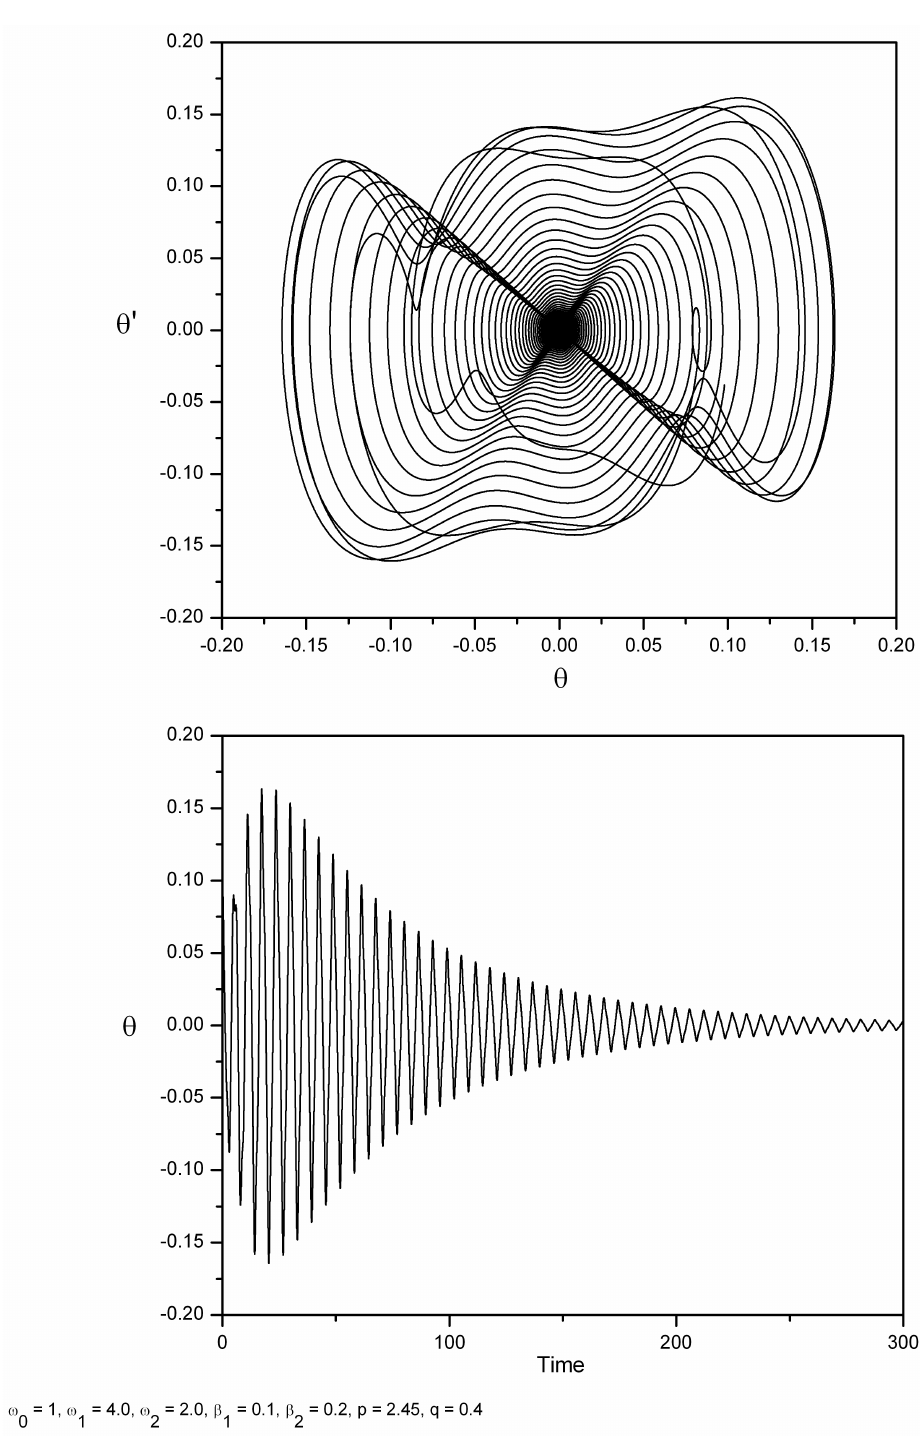
= 4 and ω = 2 for the 1 2 = 1 , β = 0 . 1 , β = 0 . 2 , p = 2 . 45 , q = 0 . 4 0 1 2